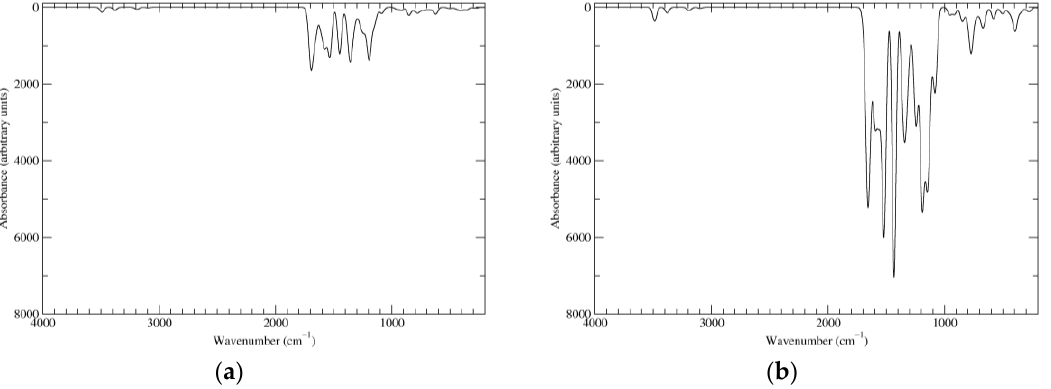
Figure 12. Computed IR spectra of the most significant tautomers/conformers in the eight-electrons oxidation state. ( a ) Neutral form in vacuo, a16_b56_c16_d56, C 2 , conf1. ( b ) Neutral form in water, a16_b56_c16_d56, C 2 , conf1.